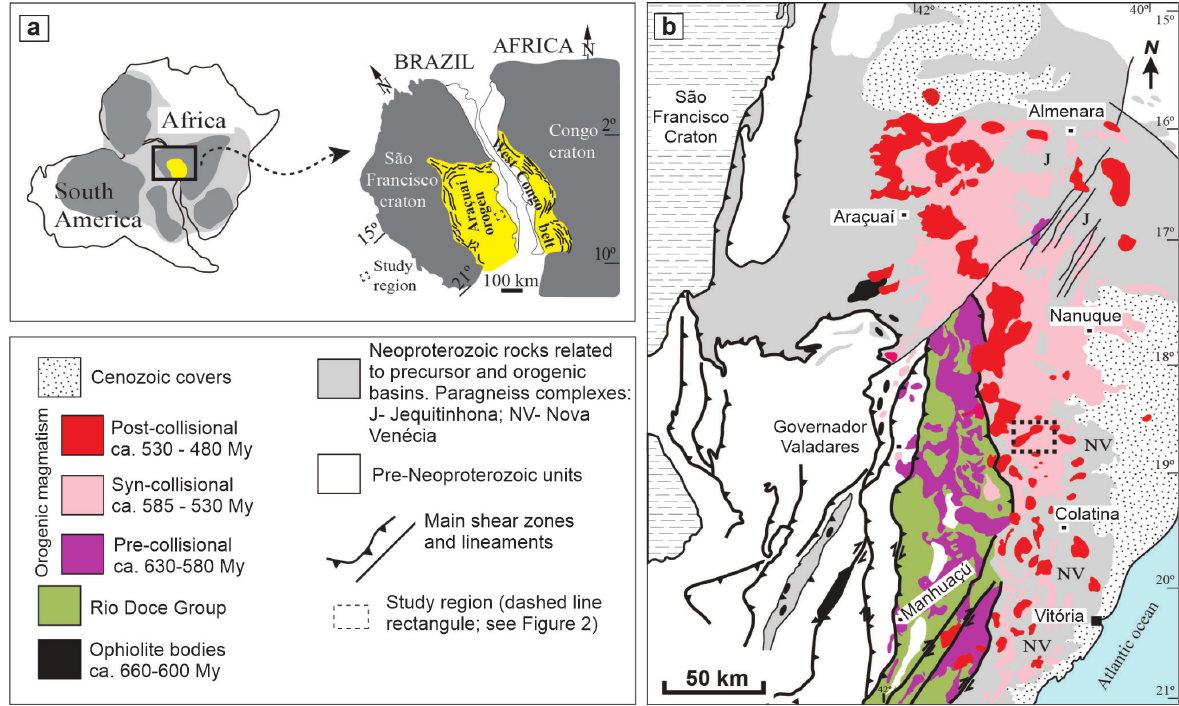
Figure 1. Gondwana scenario during amalgamation of the Araçuaí-West Congo belt. (a) Araçuaí-West Congo orogenic system and adjacent cratonic region in the context of the West Gondwana (after Alkmim et al. 2006). (b) Simplified geological map of the Araçuaí orogen (modified from Pedrosa-Soares et al. 2011), showing location of the study area (dashed